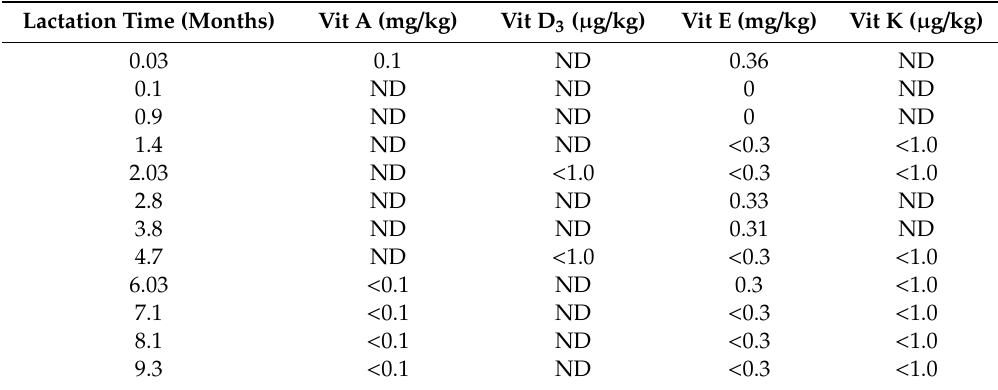
Table 1. Vitamin content of African elephant milk during